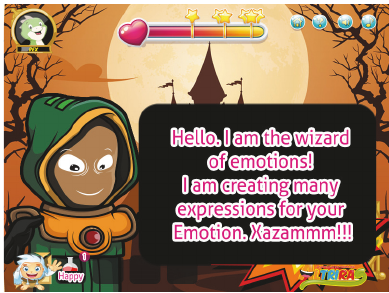
Figure 4: Home interface.